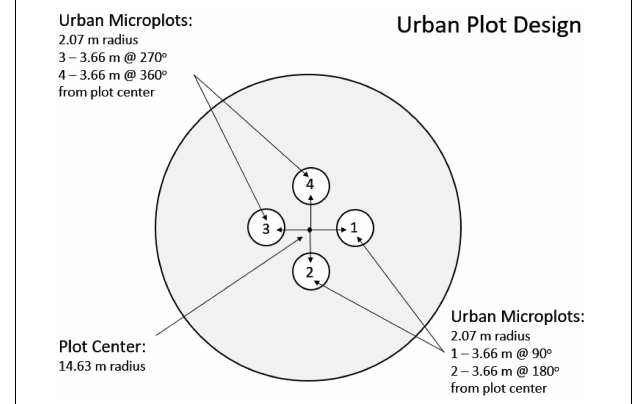
FIGURE 1 | Urban inventory plot configuration used by the United States FIA